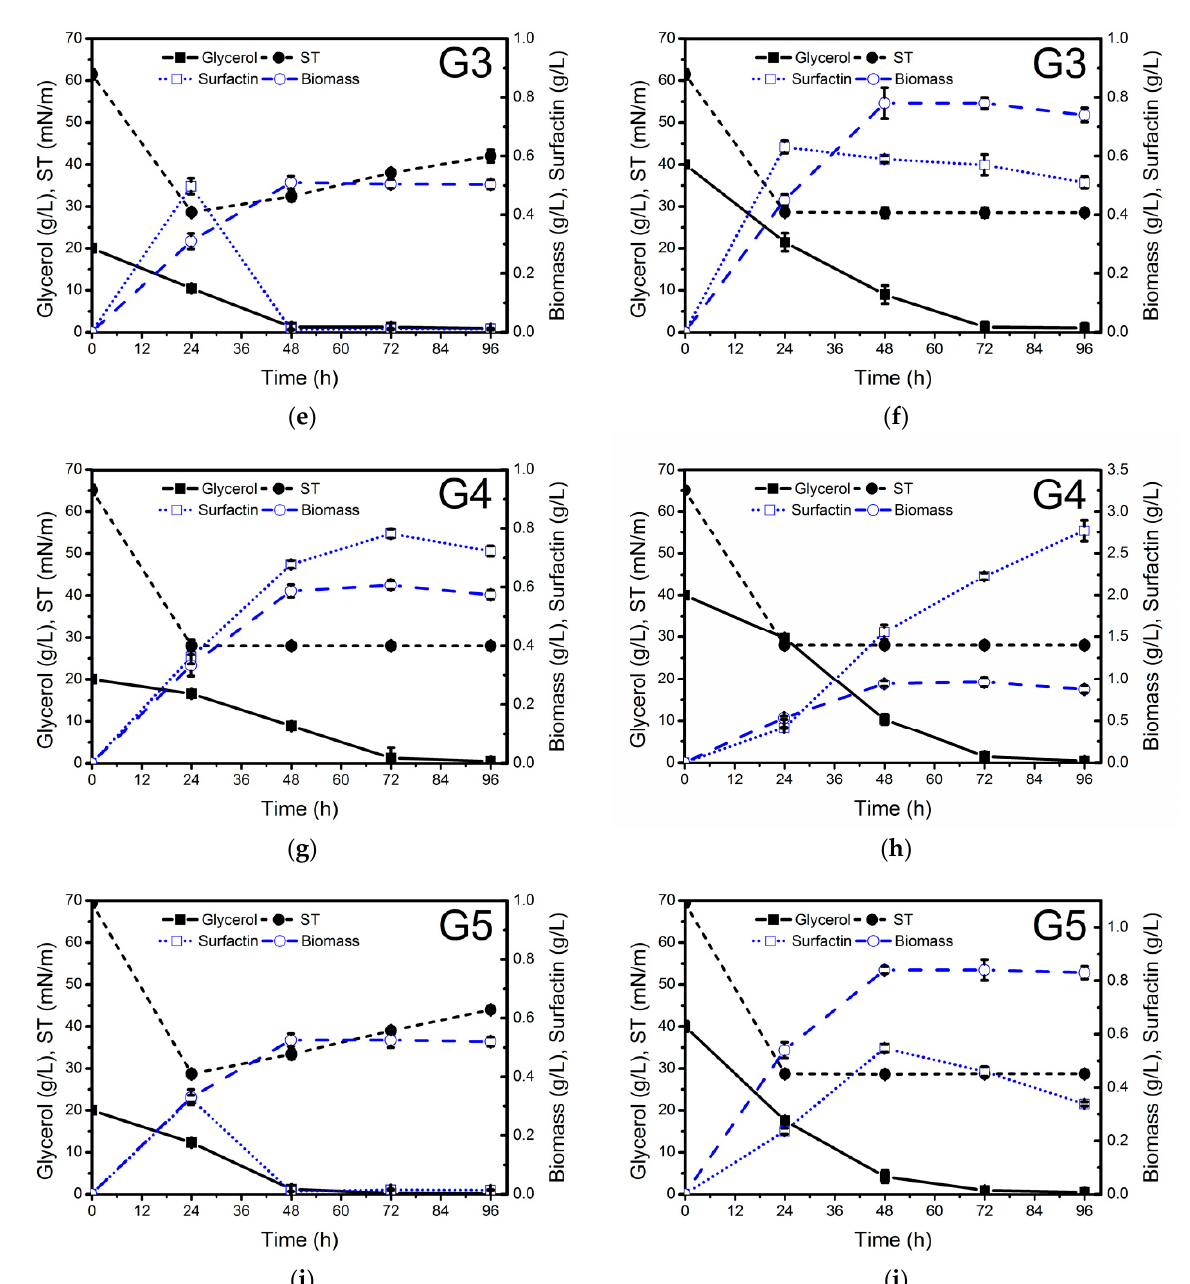
Figure 1. Glycerol consumption (g/L), biomass (g dry weight/L), surface tension (ST, mN/m) and surfactin production (g/L) by Bacillus subtilis #309 grown in a mineral salt medium (MSM) supplemented with 20 g/L ( a, c, e, g, i ) and 40 g/L ( b, d, f, h, j ) of waste glycerol (G1–G4) from different sources and pure glycerol (G5). The cultures were performed at 37 °C and 160 rpm for 96 h. The biomass concentration was determined gravimetrically, i.e., the biomass dry weight (or total solids) per liter was measured using a balance. The results represent the mean ± standard deviation of three independent experiments performed in triplicate.